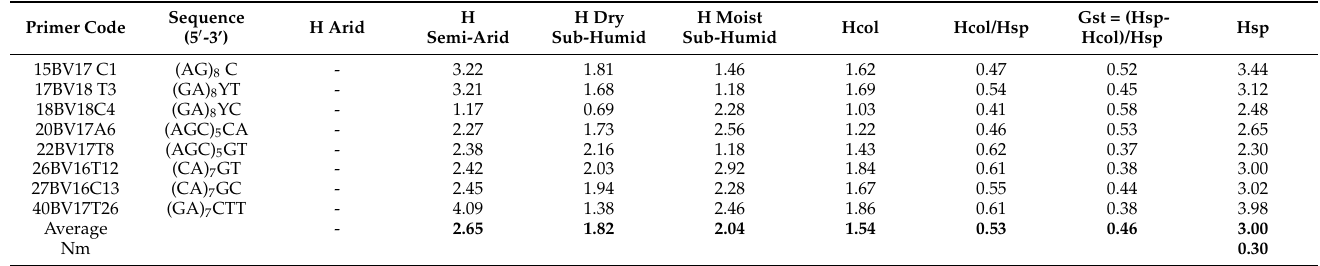
Table 5. Genetic diversity in S. cumini germplasm and Shannon diversity index based on ISSR